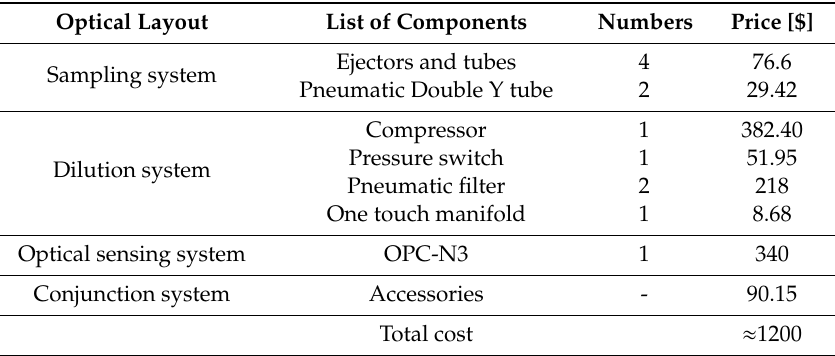
Table 5. The component cost of the